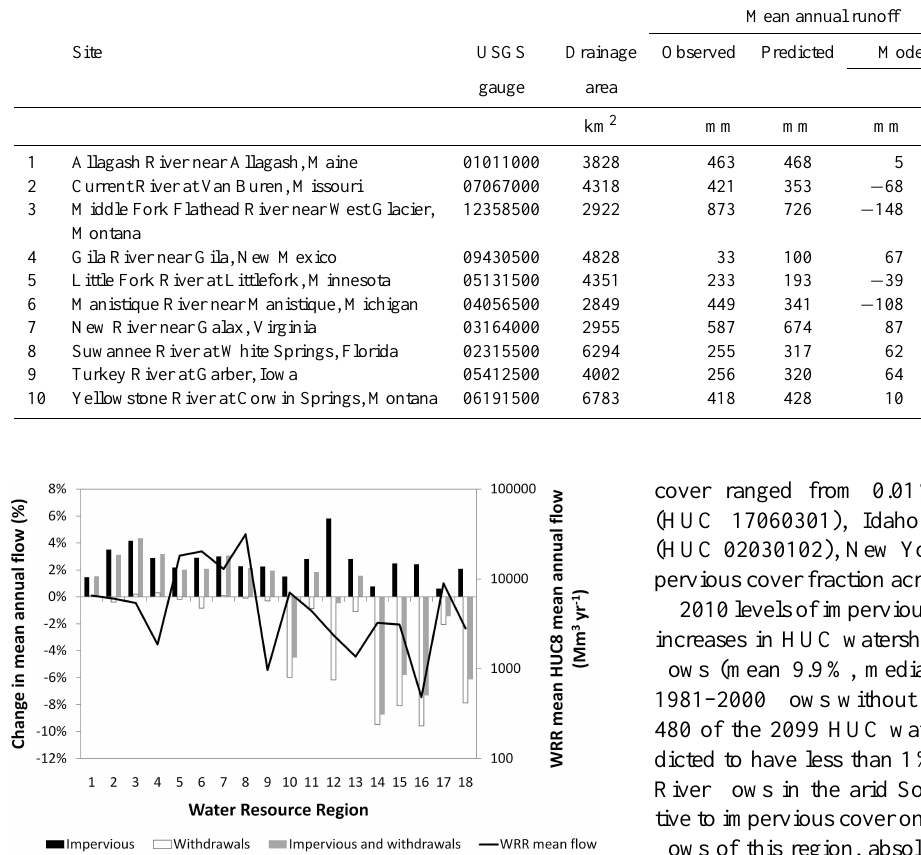
Fig. 5. Mean annual flow without impervious cover or withdrawals, and impacts of 2010 impervious cover and 2005 withdrawals on 1981–2000 mean annual flow, averaged over all 8-digit HUC water- sheds in each Water Resource